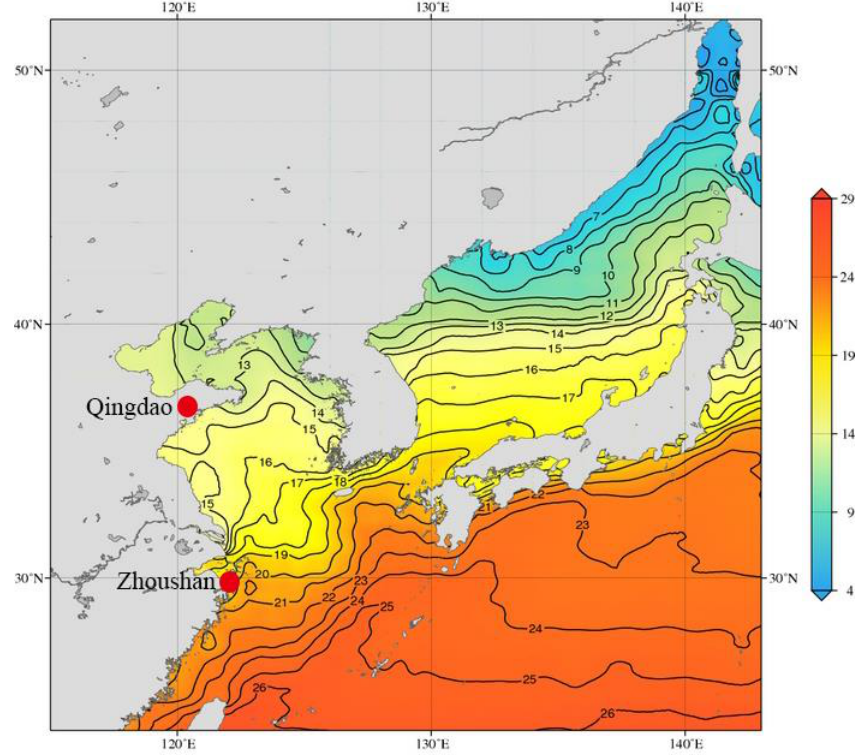
Figure 1. Map of East Asia showing annual surface temperature (°C; 10-degree grid), based on Johnson and Boyer (2015) [24].